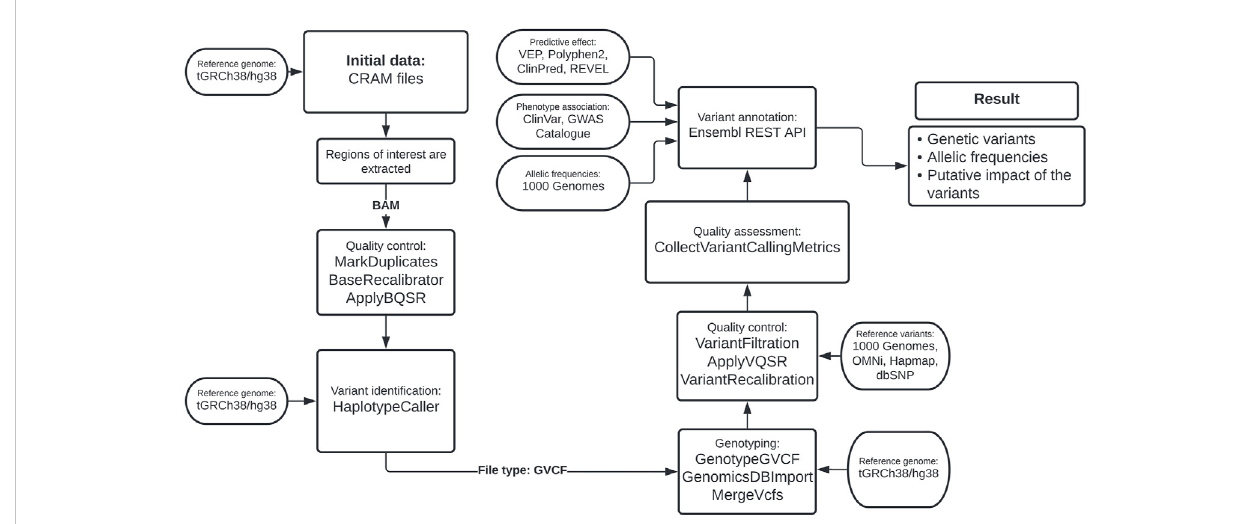
FIGURE 1 Bioinformatics pipeline based on the Best Practices Variant Calling from